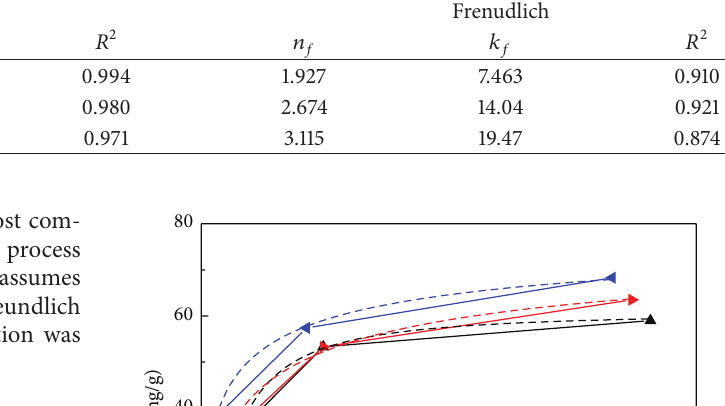
Table 3: Langmuir and Frenudlich isotherm parameters for Cr(VI) adsorption on NH Model